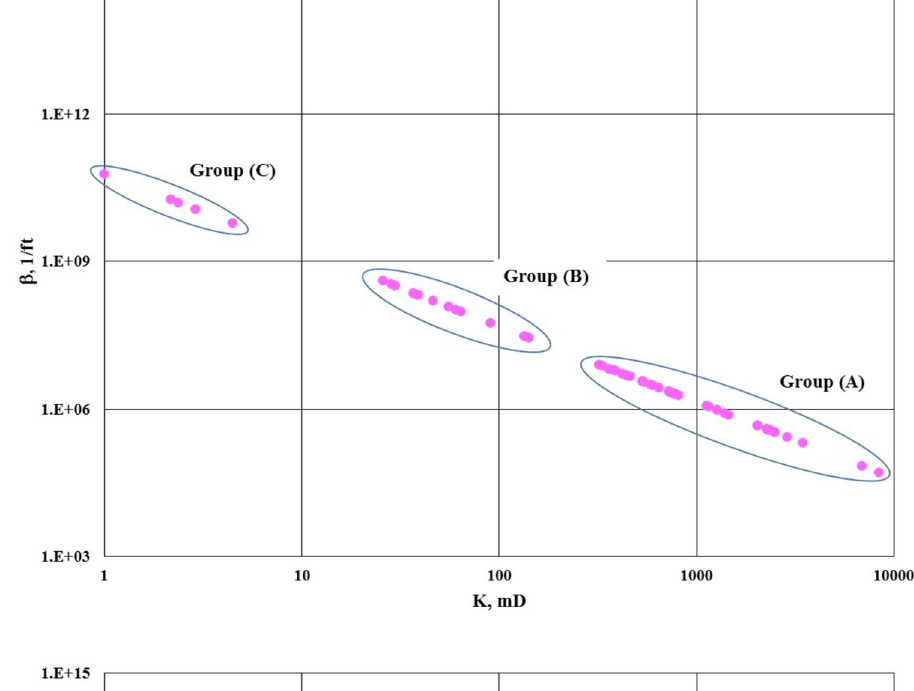
Fig. 5 Turbulence factor versus permeability (Amaefule et al.